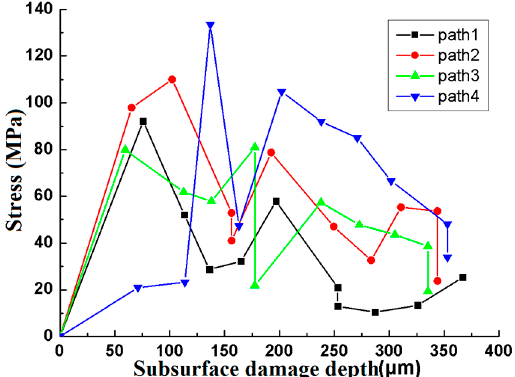
Figure 6. Relationship between stress and subsurface damage